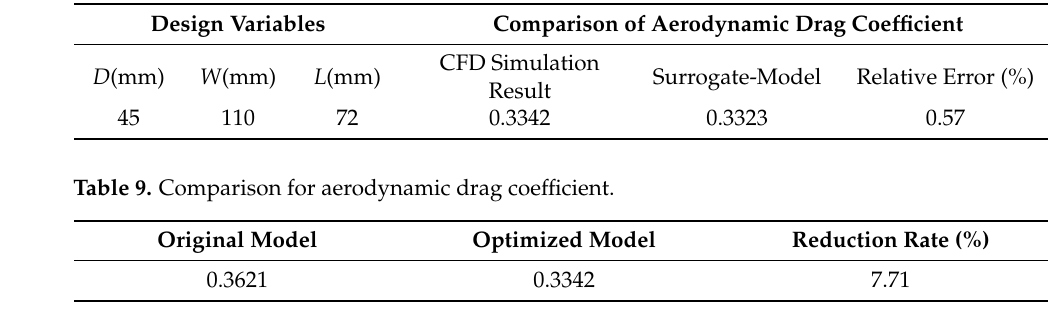
Table 8. Optimal solution.